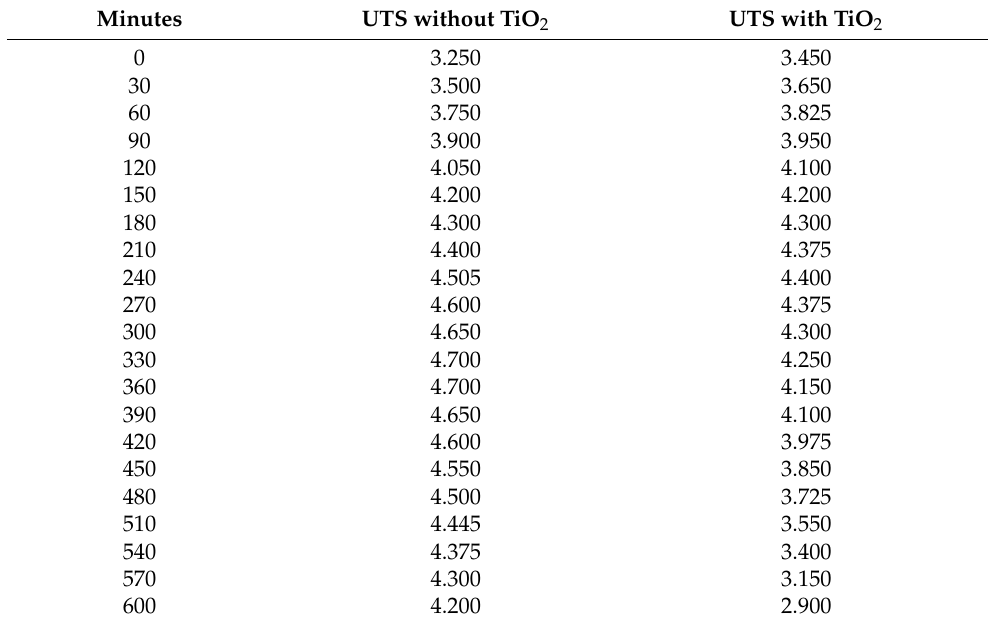
Table 3. Ultimate tensile strength (UTS) value (in Newtons) of polyamide fibers as a function of irradiation time (in minutes). Values of UTS are digitized graphs from the paper by Wiener et al. [22]. Minutes UTS without TiO 2 UTS with TiO